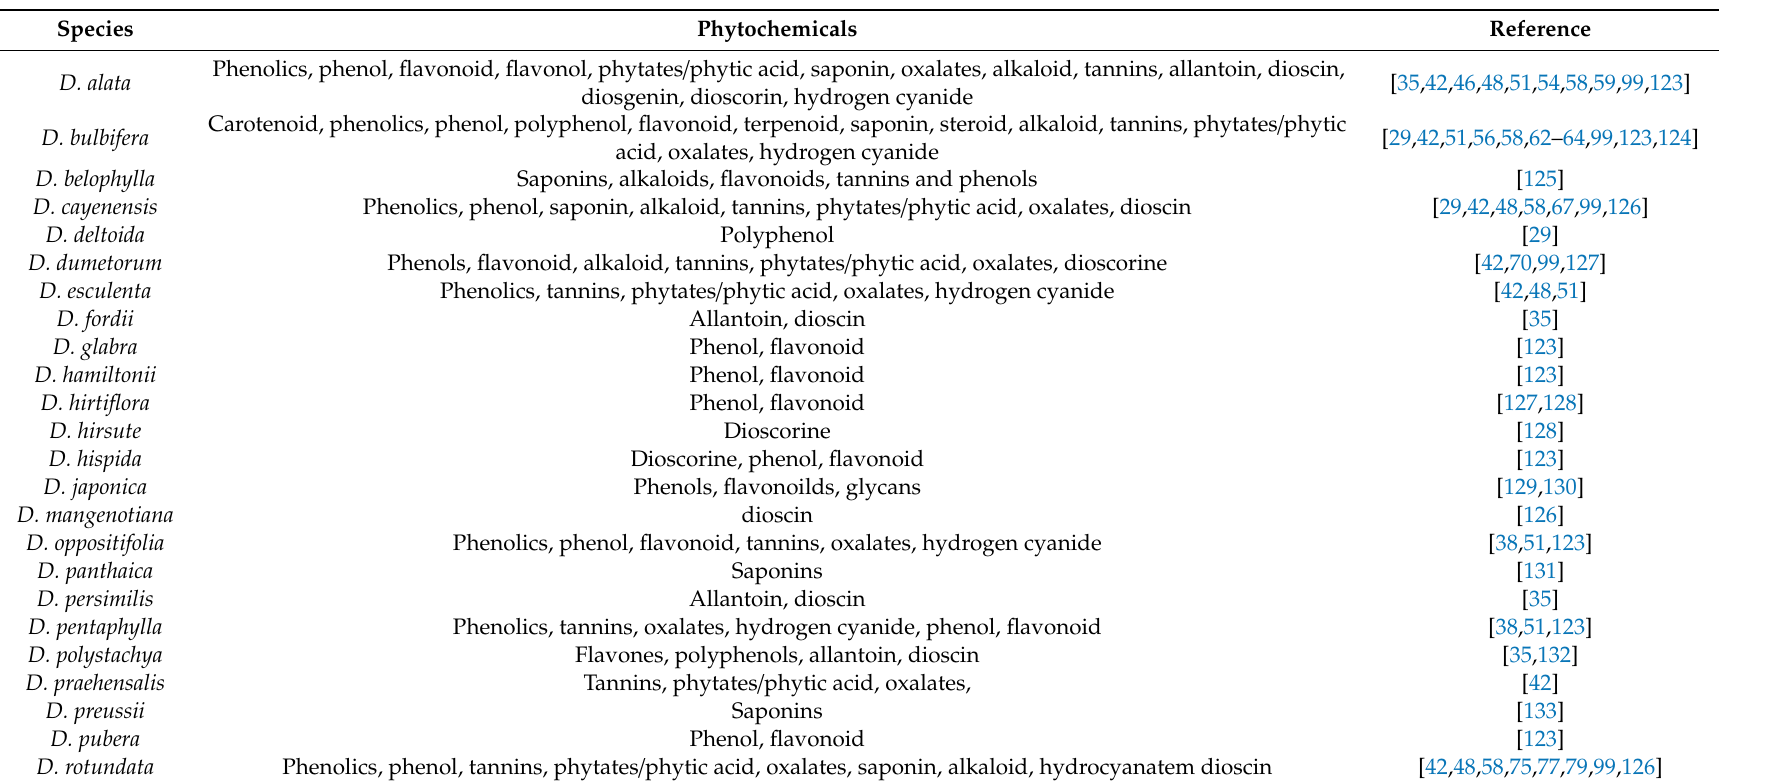
Table 3. Bioactive compound profile of yam ( Dioscorea